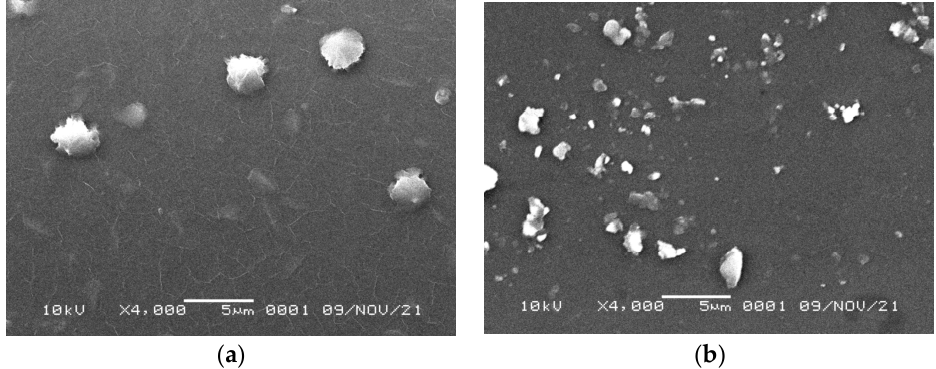
Figure 3. The morphologies of pectin–chitosan PEC ( a ) and ETH 5294/PEC pectin–chitosan mem- branes ( b ).